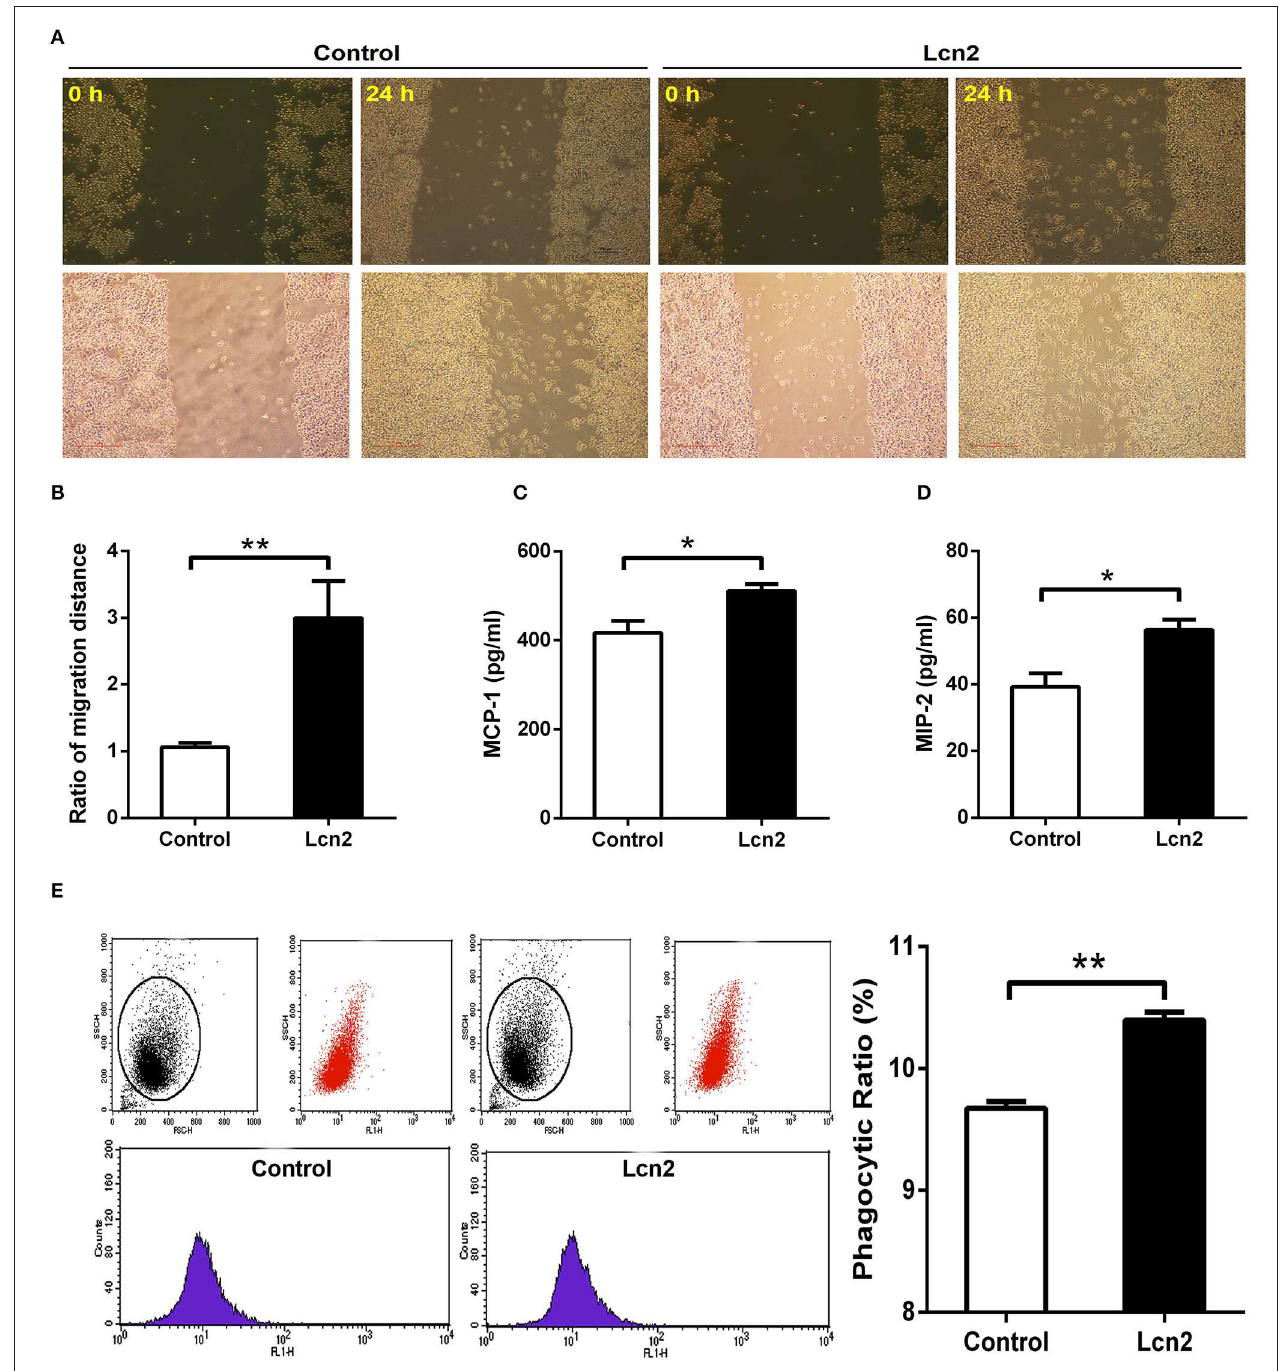
FIGURE 6 | Lipocalin 2 (Lcn2) can promote migration and phagocytosis of macrophages. (A,B) Scratch wound healing assay of mouse RAW264.7 macrophages and quantification of the fold change of average migrated distance of cells was measured with microscope ( n = 3, mean ± SEM, scale bars, 100 µ m). (C,D) ELISA analysis of monocyte chemoattractant protein (MCP)-1 and macrophage inflammatory protein (MIP)-2 levels in the culture medium of Lcn2-treated macrophages. (E) Flow cytometry analysis of mouse RAW264.7 macrophages incubated with FITC-dextran. Values are average means of triplicate experiments with two repetitions per treatment per experiment. Error bars depict SEM. * P < 0.05 and ** P <